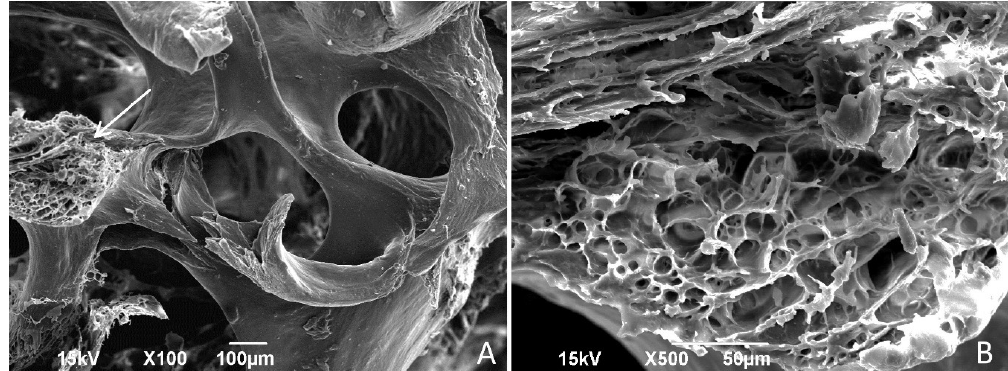
Figure 2. Architectonics of demineralized lyophilized human spongiosa (SEM). Trabecular architec- ture: ( A ) cross section of trabeculae (marked by an arrow), ×100; internal structure of the trabeculae ( B ) ×500.